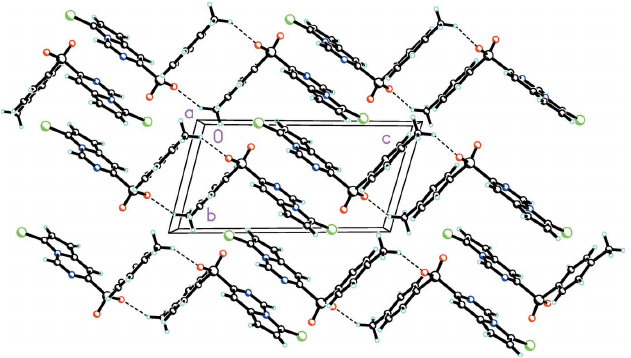
Figure 2 Packing diagram of the title compound viewed along the a axis direction showing inversion dimers linked by pairs of weak C—H (cid:3)(cid:3)(cid:3) O interactions.